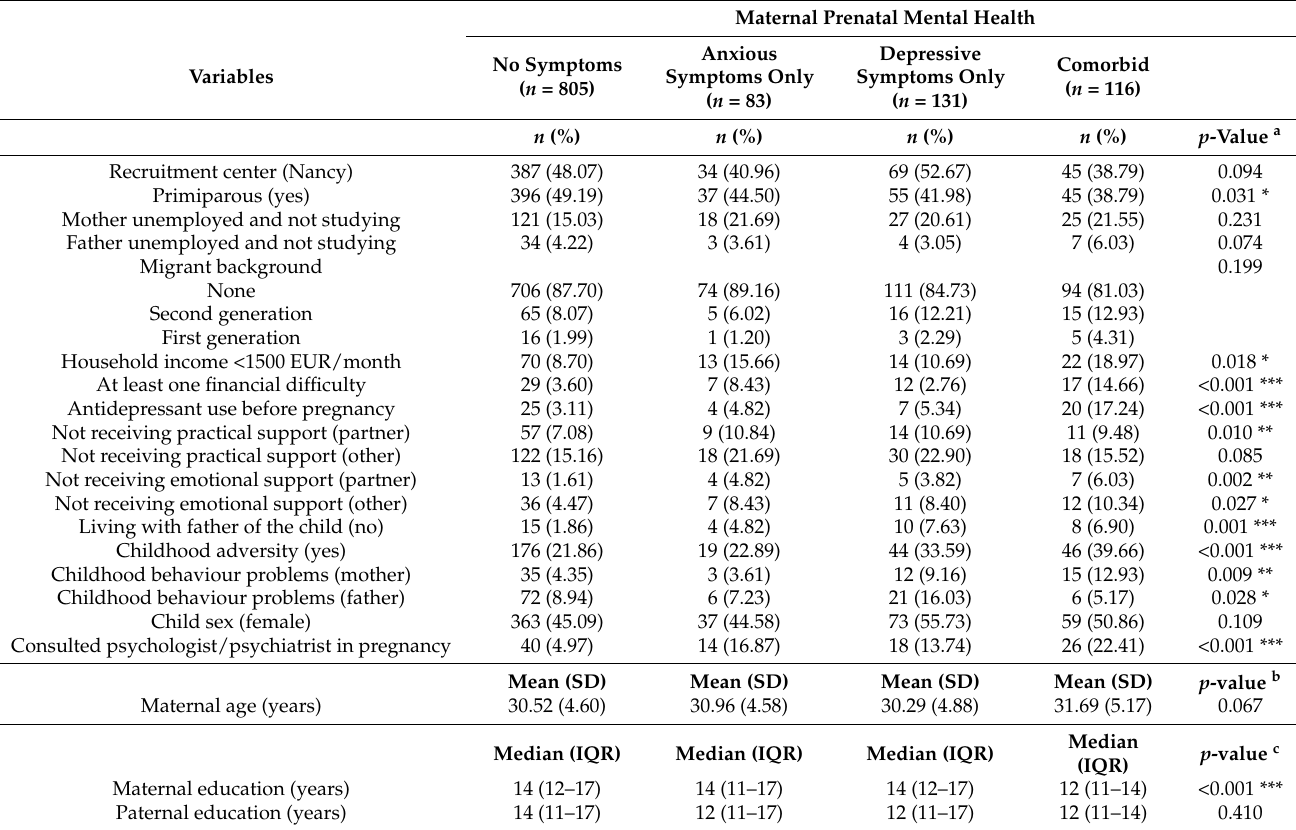
Table 1. Characteristics of the study population by mental health status classification ( n =